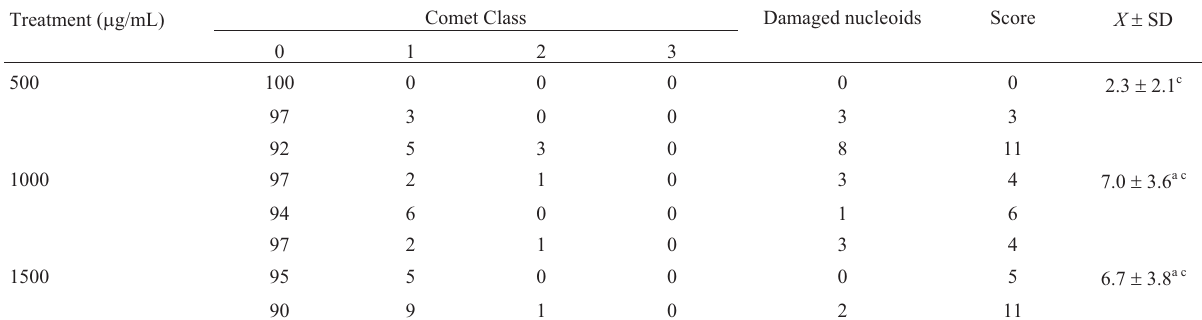
Table 4 - Numbers of micronucleated RETs (MNRET) from peripheral blood and percent damage reduction (%R) obtained in the determination of in vivo antimutagenicity of Spondias dulcis Forst F. bark ethanolic ex- tract at three concentrations, and the respective controls. Treatments N. of animals (mg/kg b.w.)